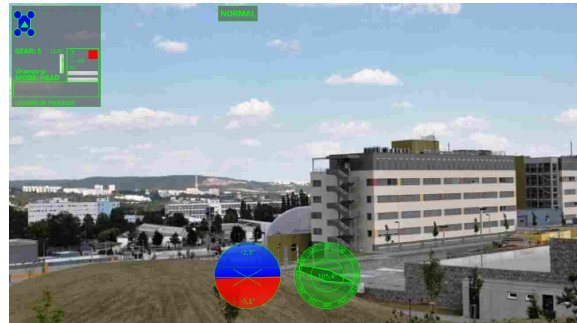
Figure 8. The user interface of the Cassandra